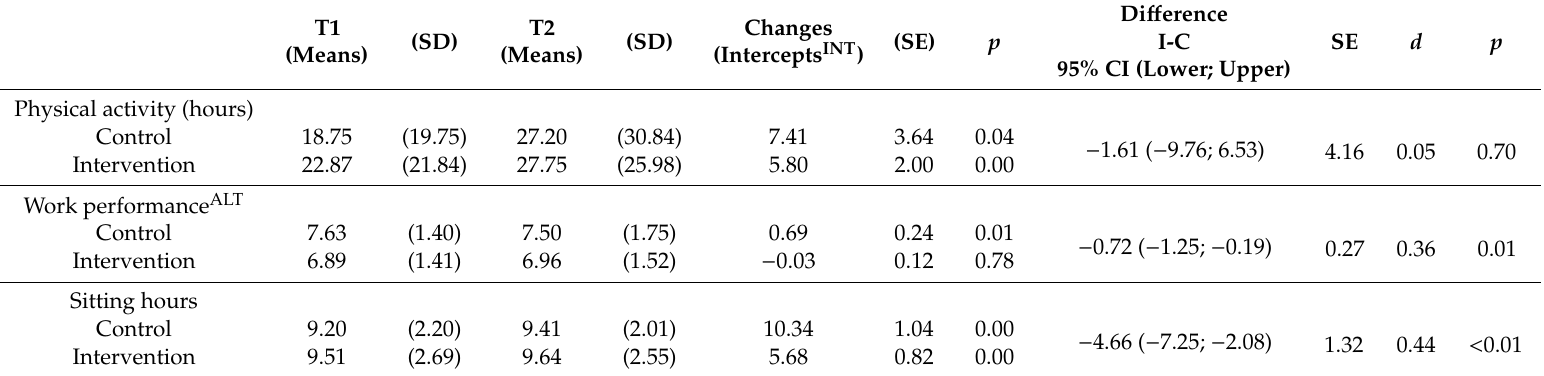
Table 3. Pre- and post-intervention outcome variables (control and intervention